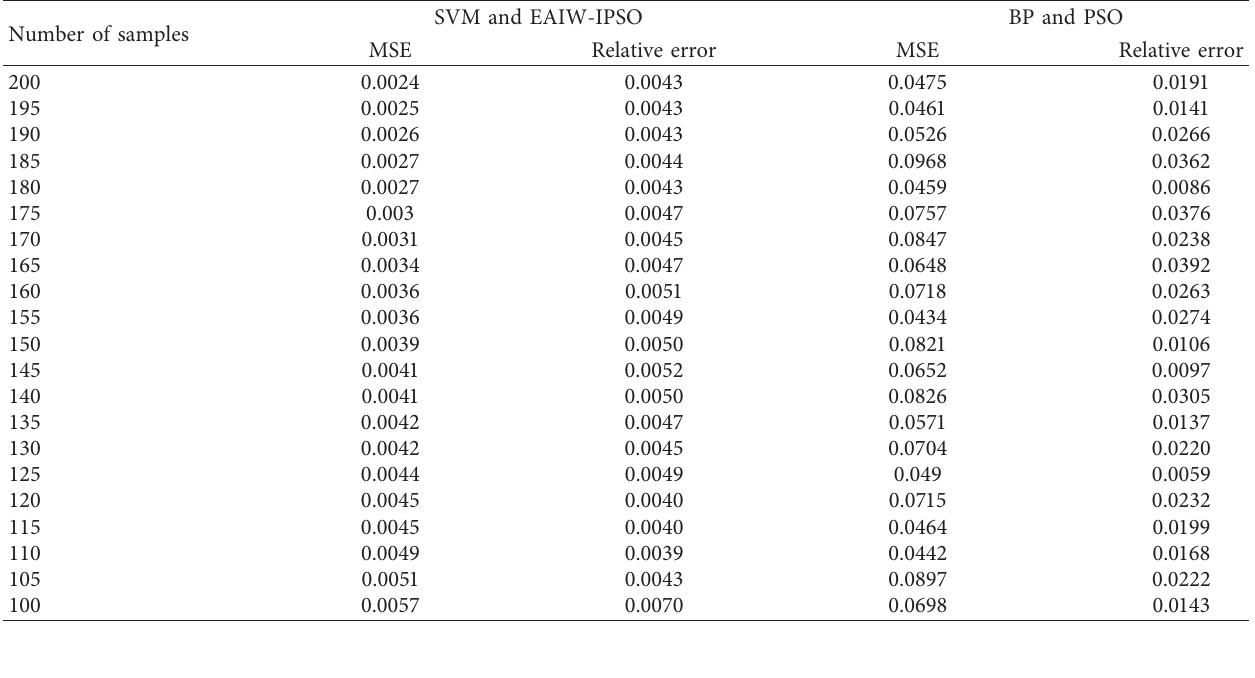
Table 1: Experimental results of the two models for the first case.